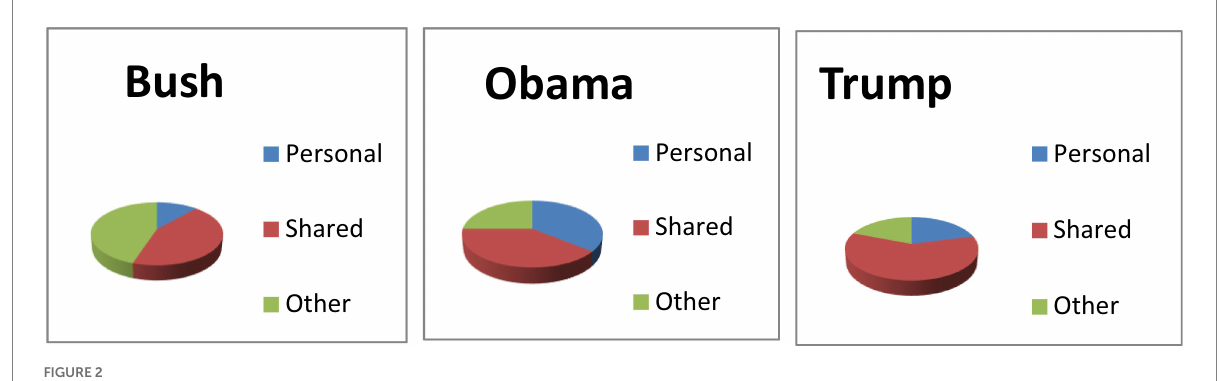
FIGURE 2 The distribution of sources of evidentials in three cases.